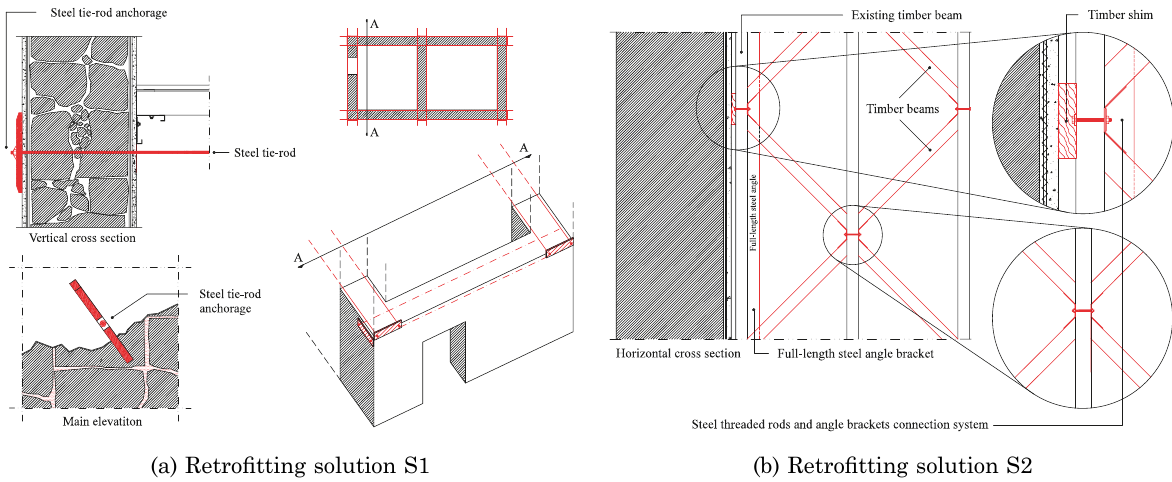
fig. 1. details of retrofitting solutions S1 (a) and S2 (b) of package rP1, adapted from Costa